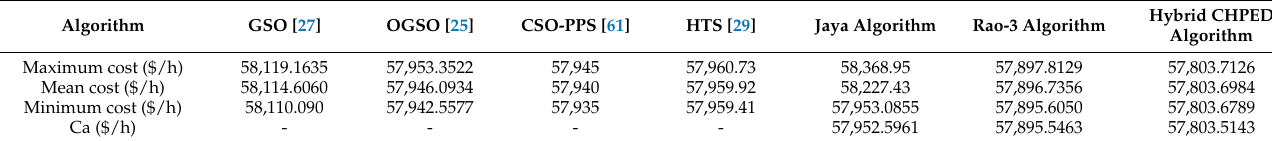
Table 6. Statistical analysis of case 2 of test system 2.